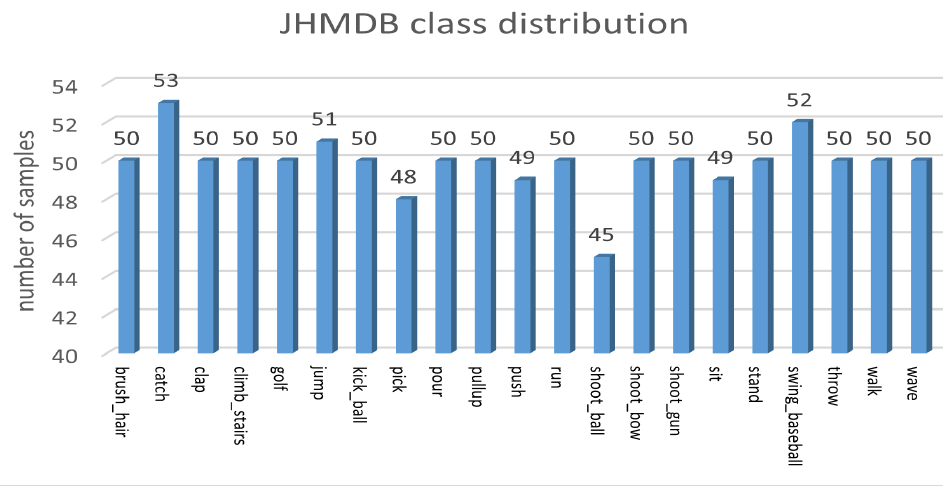
Figure 9. Number of samples per category in the JHMDB dataset after data balancing.